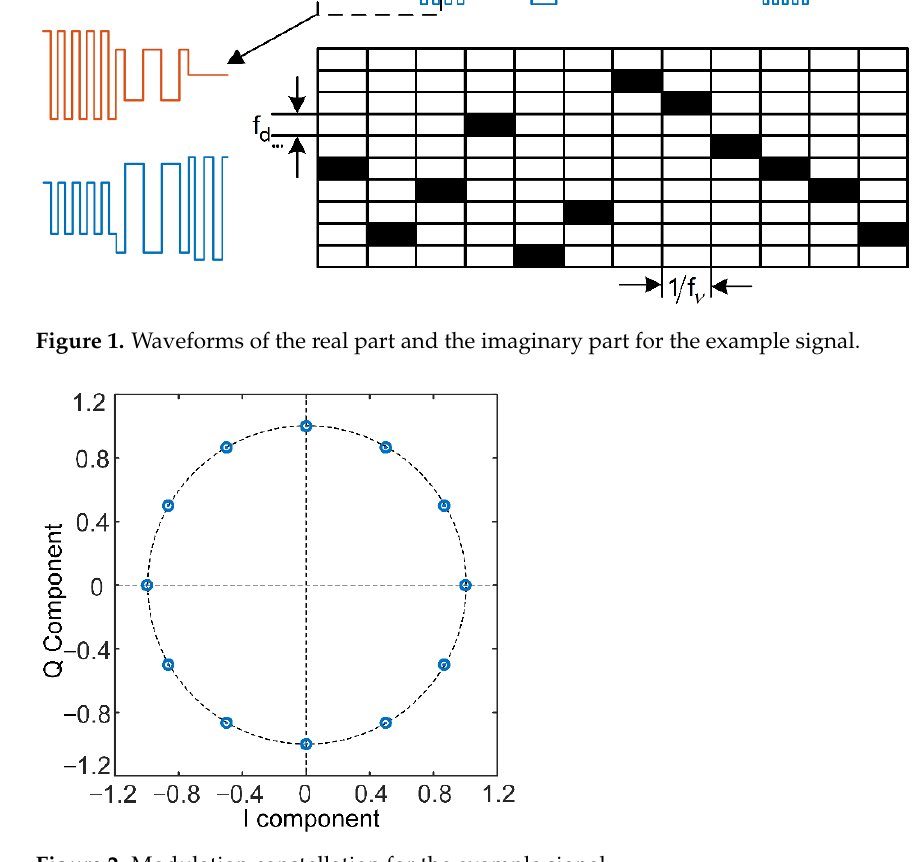
Figure 2. Modulation constellation for the example signal.